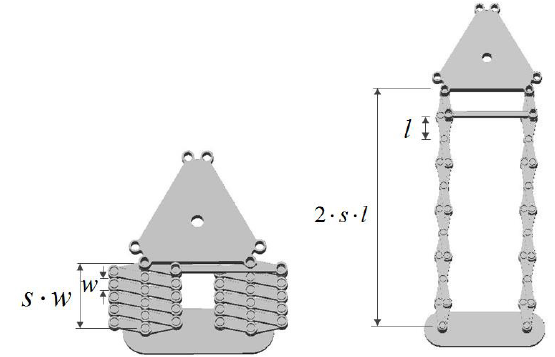
Figure 6. Minimum and maximum length of i H 1